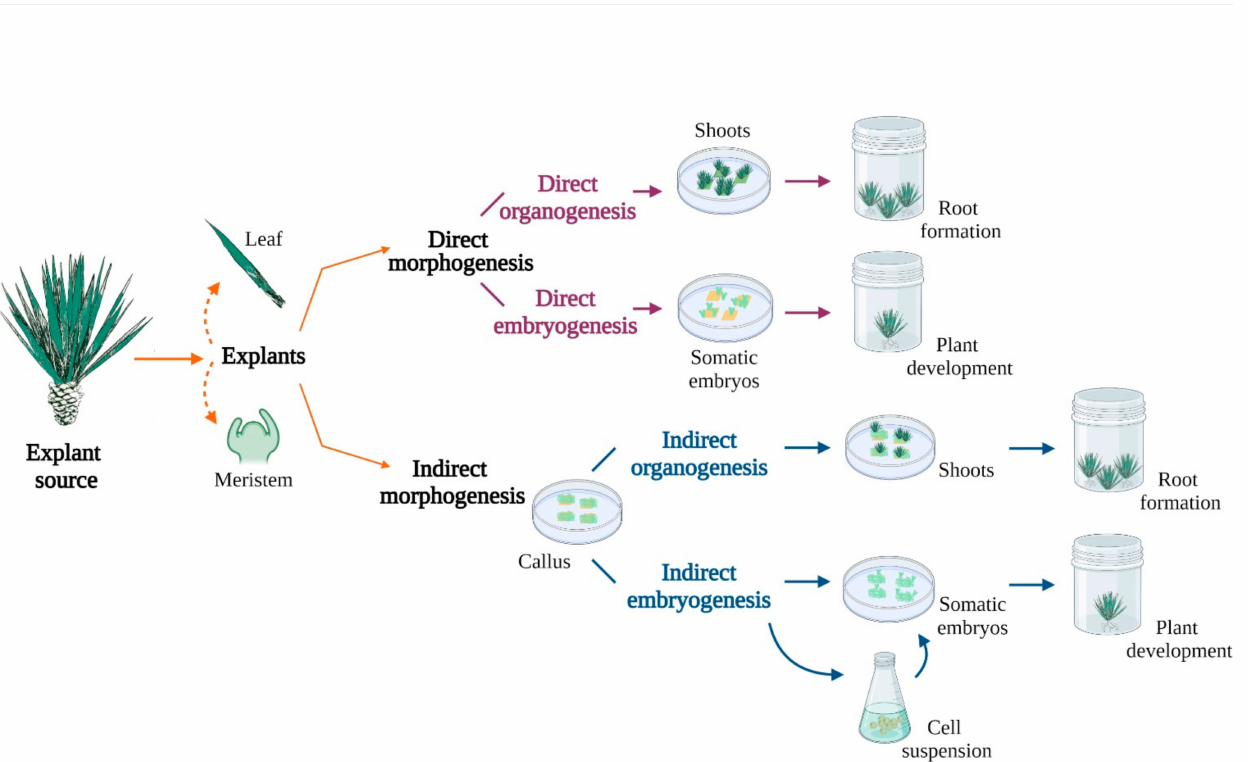
Figure 1. Regeneration responses in Agave species. Regeneration can be induced from explants, as leaf and meristem tissues. This has been carried out through different approaches such as di- rect organogenesis, allowing the development of shoots with no intervening callus; and indirect organogenesis, which is the formation of callus before the development of shoots. Direct and indirect somatic embryogenesis are also mainly used and consist of the directly formation of embryos from a cell or small group of cells, and the production of callus from the explant before the production of embryos respectively [29]. Image created with https://app.biorender.com (accessed on 14 February